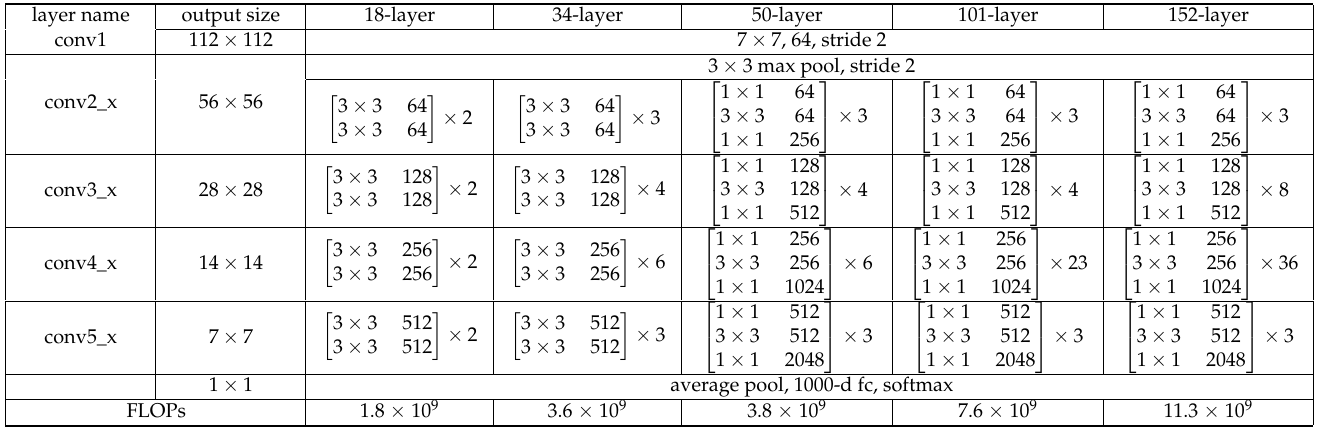
Figure 2. Residual learning structure [12]. Table 2. Architecture of ResNet [12] .